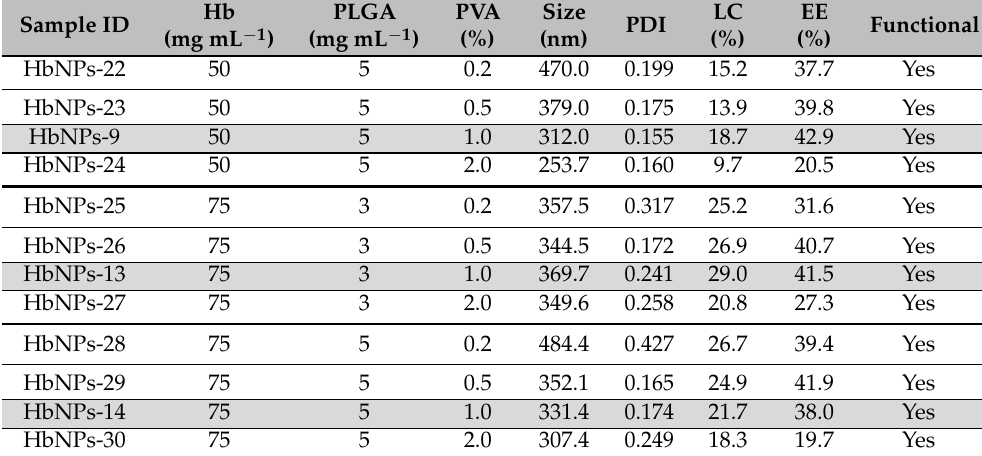
Table 4. Effects of the PVA concentration on the size, polydispersity (PDI), loading content (LC), entrapment efficiency (EE) and functionality of the resulting